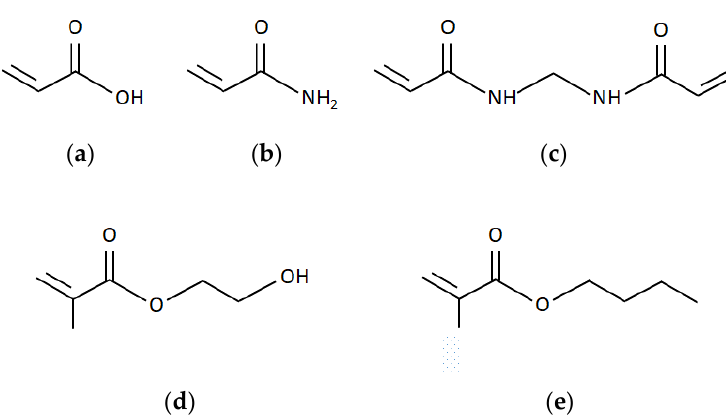
Figure 1. Chemical structure of the monomers and crosslinker: ( a ) Acrylic acid; ( b ) Acrylamide; ( c ) Methylene bisacrylamide; ( d ) 2-Hydroxy ethyl methacrylate; ( e ) Butyl methacrylate.